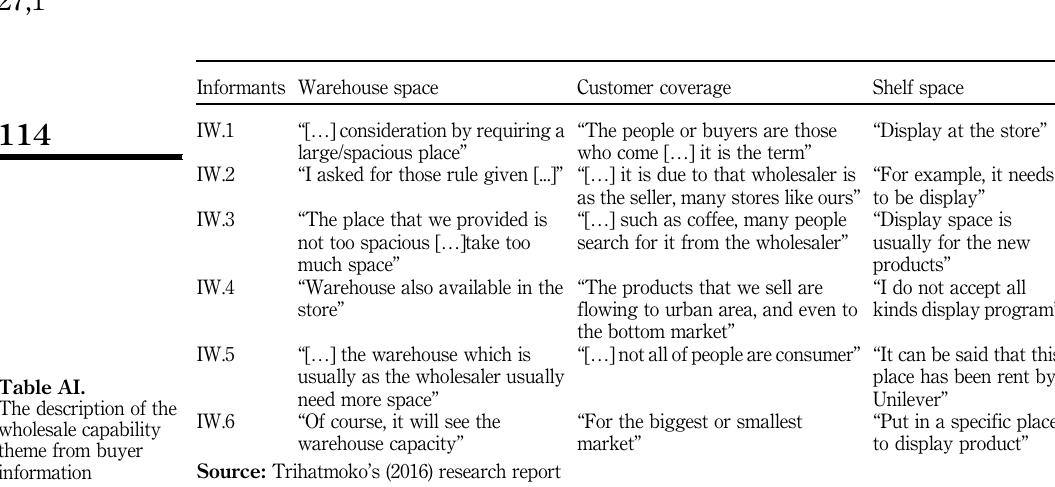
wholesale capability theme from